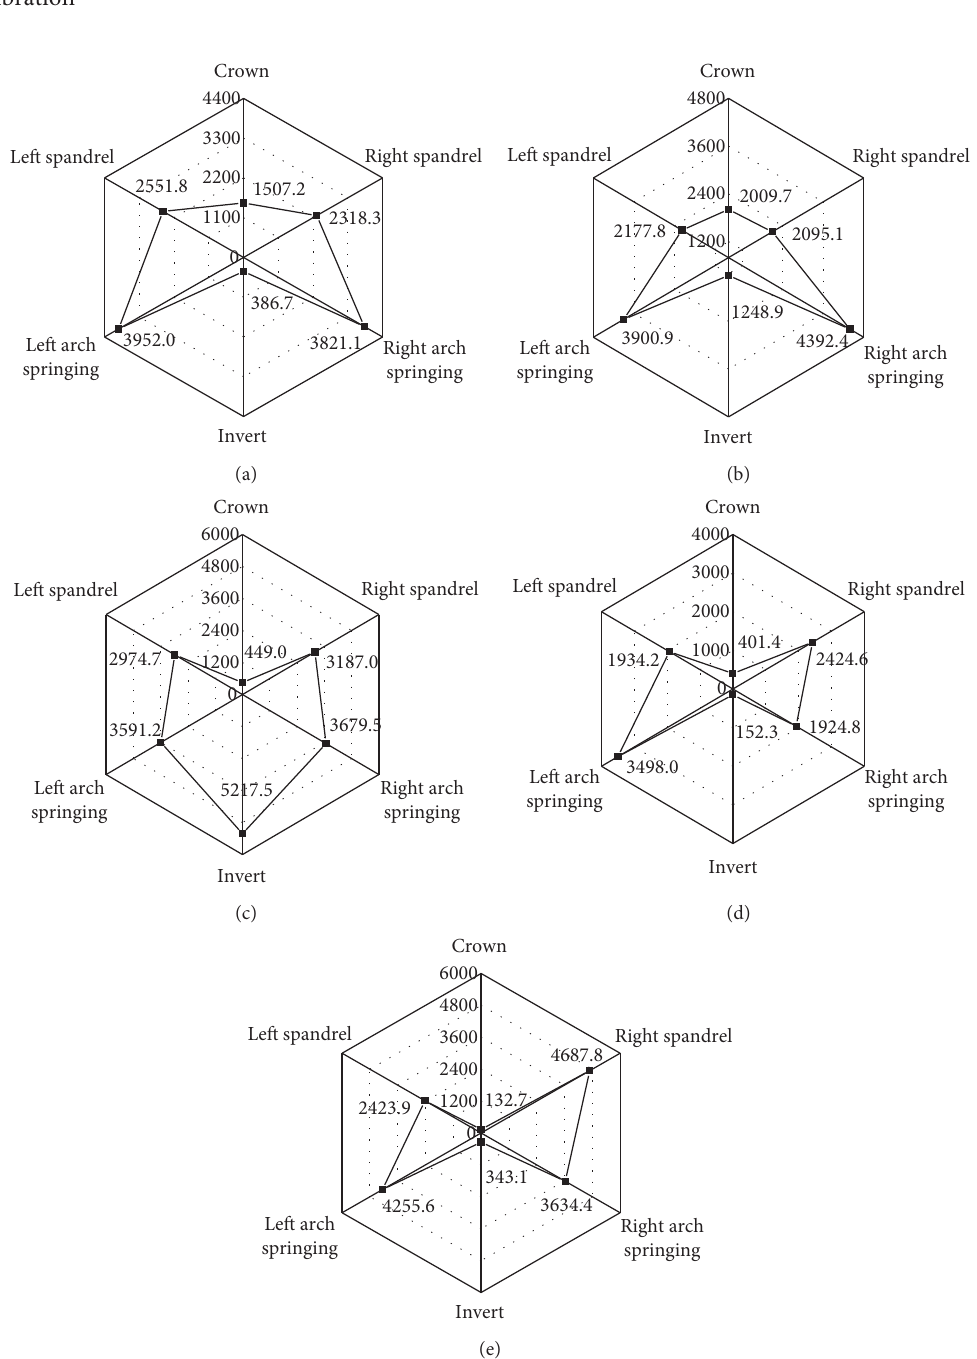
Figure 5: Accumulated elastic strain energy diagrams of tunnel structures with different ratios of width to height (unit: J). (a) 0.68; (b) 0.76; (c) 0.92; (d) 1.33; (e)